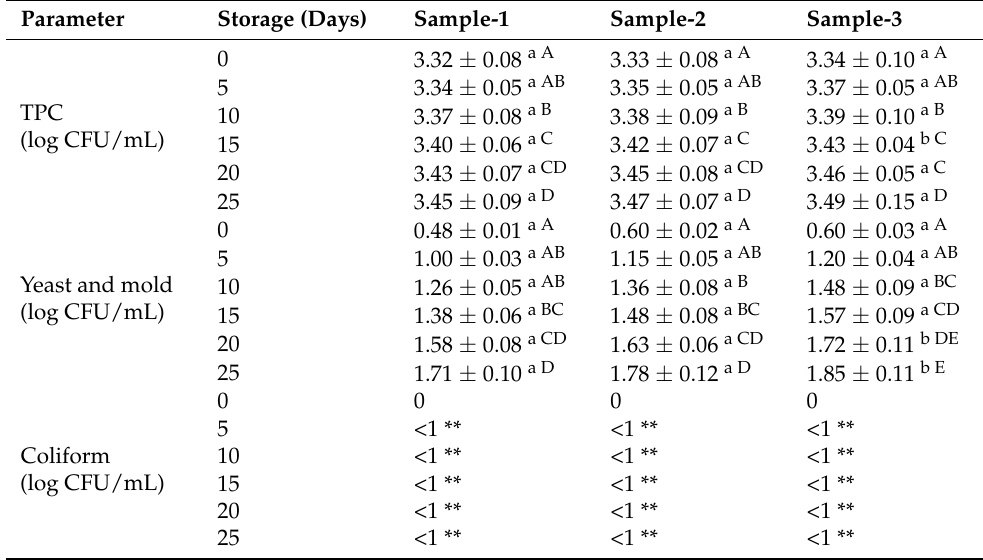
Table 4. Microbiological analysis of whey-mango based mixed beverages during storage 1